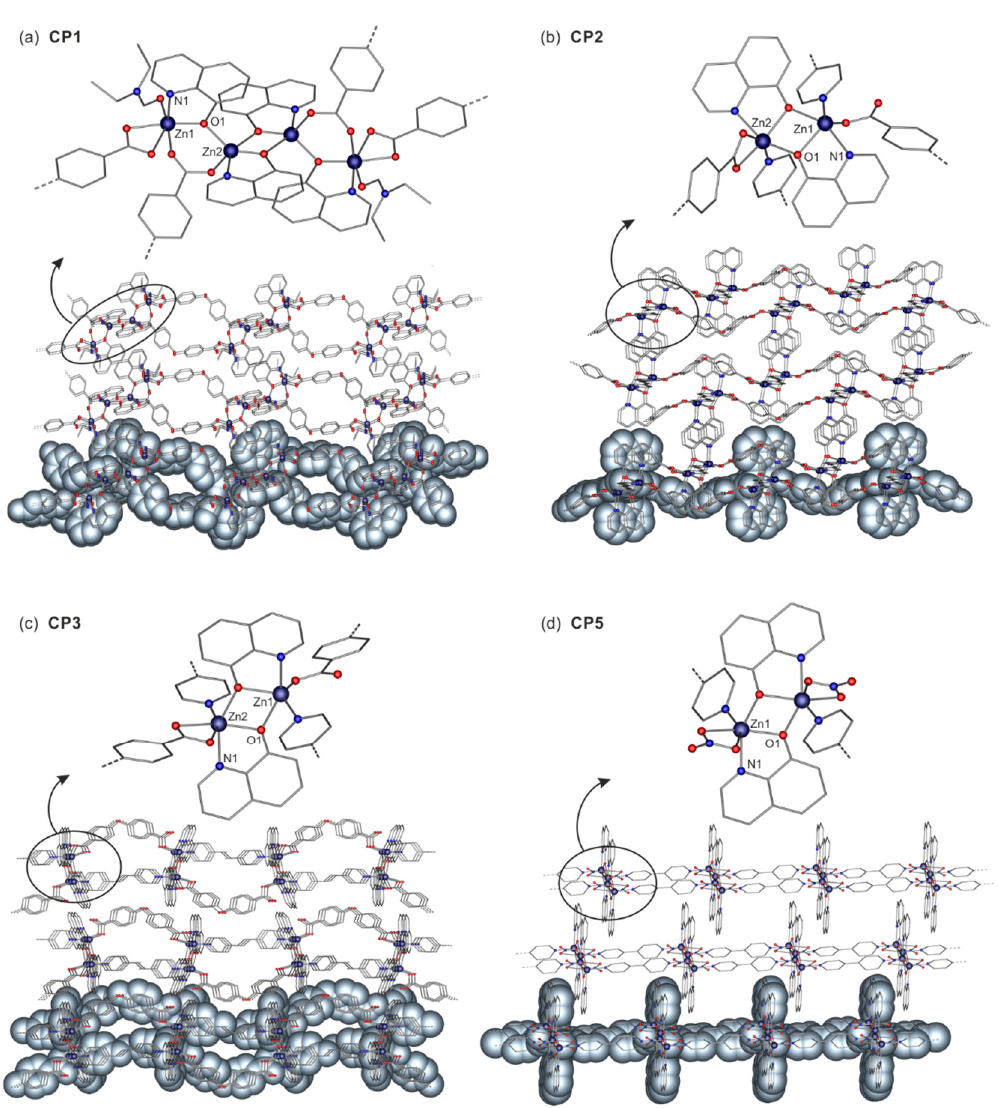
Figure 1. Molecular and supramolecular structures of CP1 ( a ), CP2 ( b ), CP3 ( c ) and CP5 ( d ). Zinc = violet, Oxygen = red, Nitrogen = blue, Carbon = grey. Most of the hydrogen atoms have been omitted for clarity.